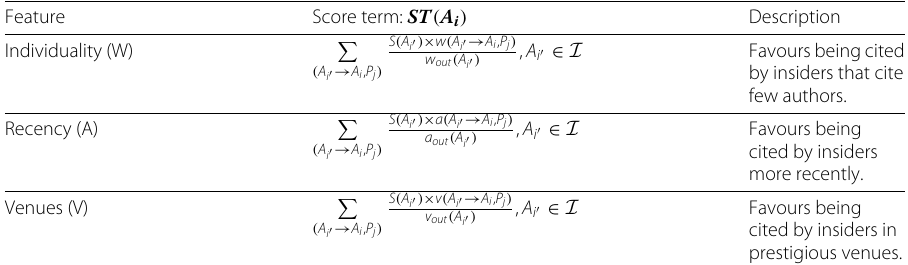
Table 4 List of features used for OTARIOS’ author score term calculation: ST ( A i ) Feature Score term: ST ( A i ) Description Individuality (W)